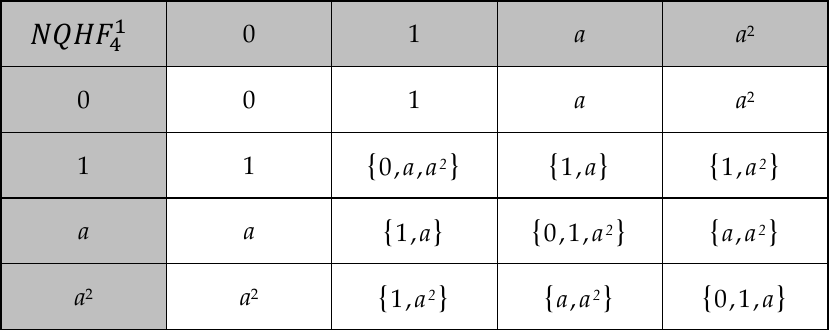
Table 10. The Cayley table of the additive canonical hypergroup of the non-quotient b-hyperfield with 4 elements.